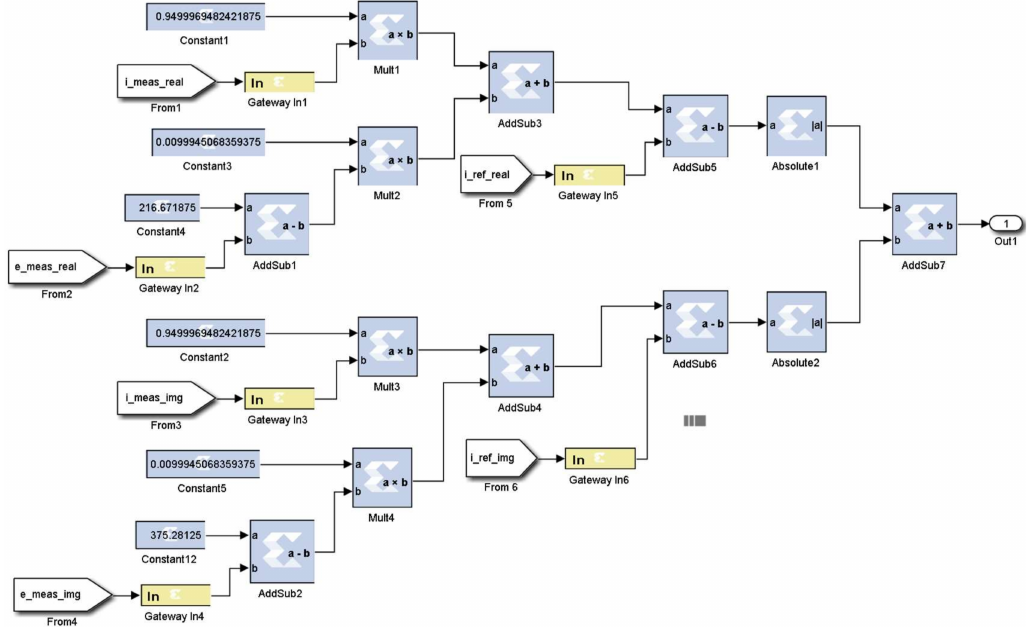
Figure 5. Computation of a cost function in the